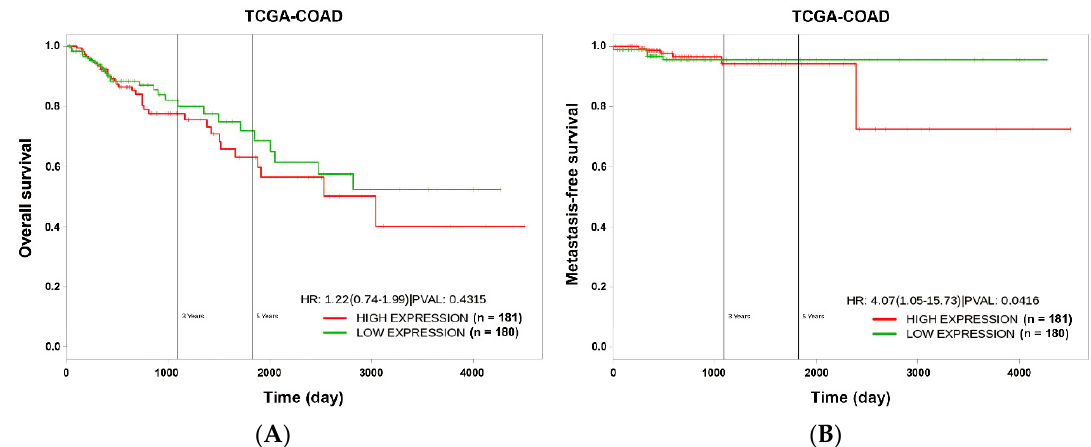
Figure 1. The prognostic impact of microRNA-21-5p (miR-21) on overall ( A ) and metastasis-free ( B ) survival in colorectal cancer (CRC). The prognostic impact of miR-21 in CRC was analyzed using the PROGmiR database (http://www.compbio.iupui.edu/progmir). The input “has-mir-21” was queried, and Kaplan–Meier survival plots were generated based on the expression data of colon adenocarcinoma (COAD) from The Cancer Genome Atlas (TCGA; https://tcga-data.nci.nih.gov/tcga). Patients with high ( n = 181) and low ( n = 180) miR-21 expression were bifurcated at the median value. HR, hazard ratio; PVAL, p value.